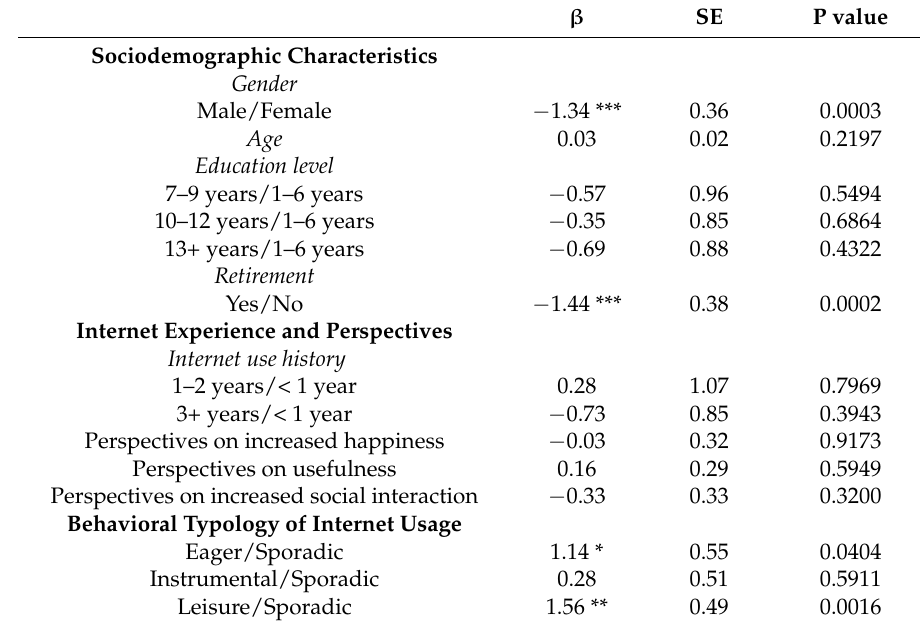
Table 4. Net effect of Internet usage typology in predicting social engagement